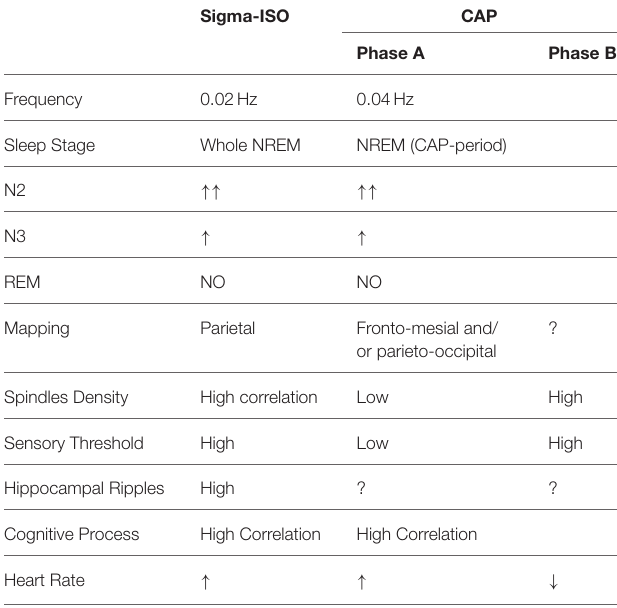
TABLE 1 | Similarities and differences between oscillations of the EEG power in the sigma frequency band (sigma-ISO, infra-slow oscillation) and the Cyclic Alternating Pattern